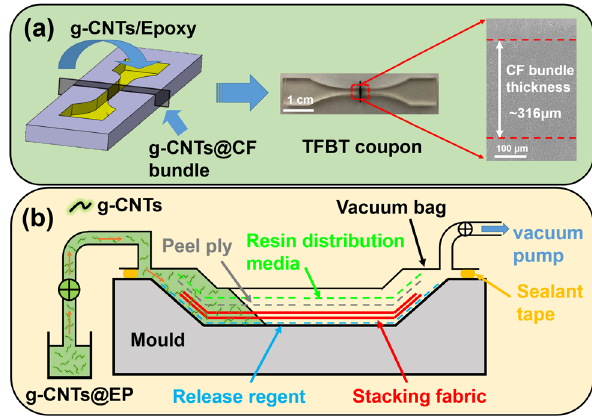
Figure 2: Fabrication of TFBT ( a ) and CFRP ( b ) samples strengthened via g -